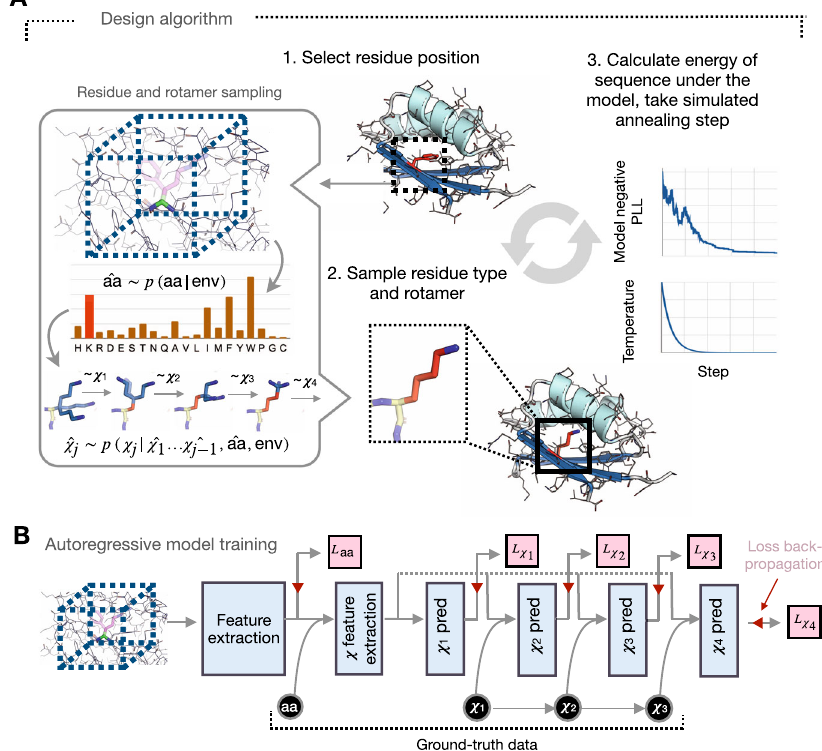
Fig. 1 Fully learned sequence and rotamer design onto fi xed protein backbones. A Sequences are designed onto fi xed protein backbones by (1) iteratively selecting a candidate residue position, (2) using a neural network model to sample amino-acid type and conformation, and (3) optimizing the negative pseudo-log-likelihood of the sequence under the model via simulated annealing. (Inset, left) Given the local chemical environment around a residue position (box, dashed, not to scale), residue type and rotamer angles are sampled from network-predicted distributions. B The neural network model is trained to predict residue identity and rotamer angles in an autoregressive fashion, conditioning on ground-truth data (black). The trained classi fi er predicts amino-acid type as well as rotamer angles conditioned on the amino-acid type. Cross-entropy loss objectives are shown in